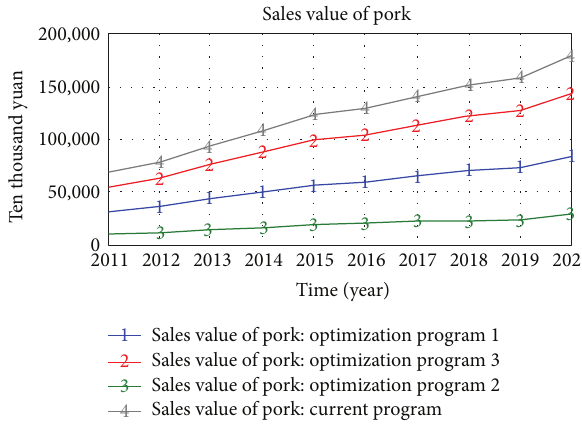
Figure 10: The sales value of pork.